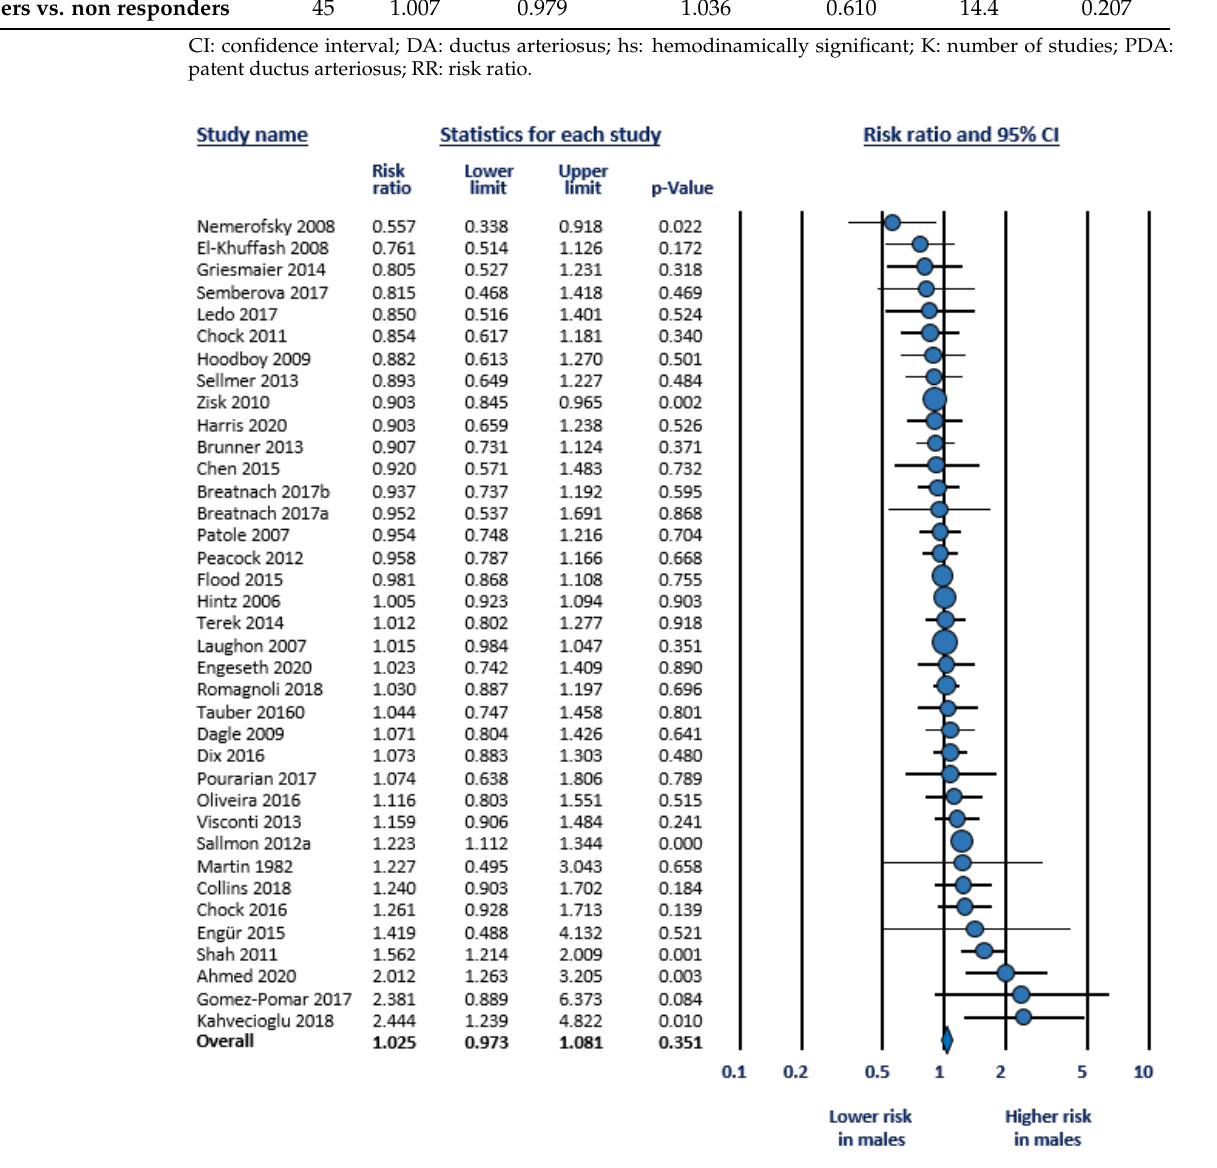
Figure 1. Meta-analysis on the association between sex of preterm newborns and risk of developing any patent ductus arteriosus (PDA). Any ductal shunt was compared with closed DA. The median incidence of PDA in the cohorts was 49.8% (range 12.4 to 82.4%); CI: confidence interval; Risk ratio above 1 means higher risk in males.